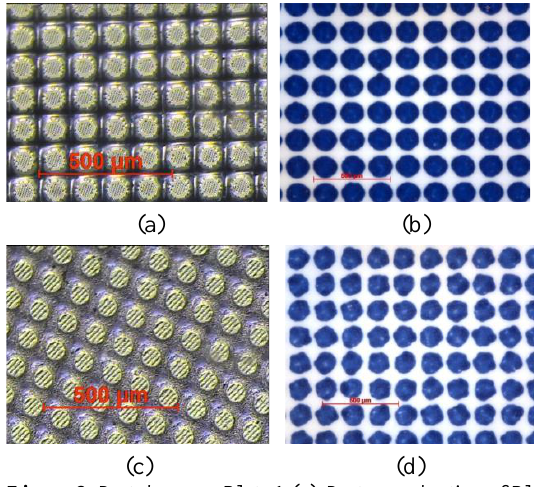
Figure 3. Dot shape on Plate 1 (a), Dot reproduction of Plate 1 (b), Dot shape on Plate 2 (c), Dot reproduction of Plate 2